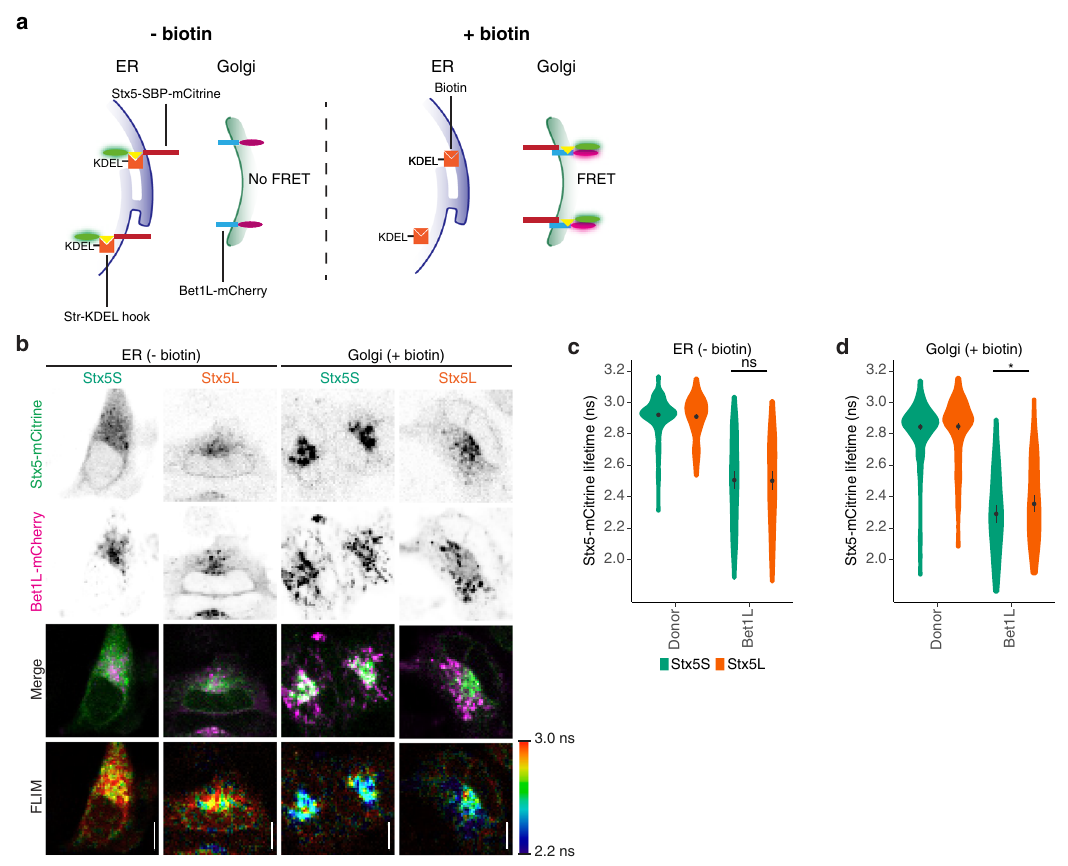
Fig. 6 Stx5S is the dominant Qa-SNARE for intra-Golgi traf fi cking. a Schematic overview of experimental design for complex formation of Stx5 isoforms with Bet1L, based on the RUSH system and SNARE complex measurement by FRET-FLIM. In the absence of biotin (left panel), the reporter cargo (Stx5- SBP-mCitrine) is trapped at the ER by the lumenal Str-KDEL hook, and no FRET with Golgi-localized Bet1L-mCherry occurs. When biotin is added (right panel), biotin outcompetes the interaction with streptavidin, allowing Stx5-SBP-mCitrine to traf fi c freely to its destination compartment, and SNARE complex formation with Golgi-localized Bet1L-mCherry results in FRET. SBP, streptavidin-binding protein; Str, streptavidin; FRET, Förster resonant energy transfer. FLIM, fl uorescence lifetime imaging microscopy. b Representative confocal micrographs and FLIM images of HeLa cells co-expressing Stx5- mCitrine (green in merge) and Bet1L-mCherry (magenta) without (ER) or with (Golgi) biotin. Scale bars, 10 µ m. c , d Stx5-mCitrine lifetimes at the ER ( c ) and Golgi ( d ) from panel ( b ). Donor: donor-only control with cells only expressing Stx5S-SBP-mCitrine or Stx5L-SBP-mCitrine. N = 210 (Stx5S Donor ER), 202 (Stx5L Donor ER), 93 (Stx5S Bet1L ER), 83 (Stx5L Bet1L ER), 228 (Stx5S Donor Golgi), 228 (Stx5L Donor Golgi), 88 (Stx5S Bet1L Golgi), and 88 (Stx5L Bet1L Golgi) cells from four to six independent experiments. Mean± 95% CI. Paired two-sided Student ’ s t -test after taking the average for each experiment. ns: not signi fi cant; * P = 0.012. Donor-only controls are not signi fi